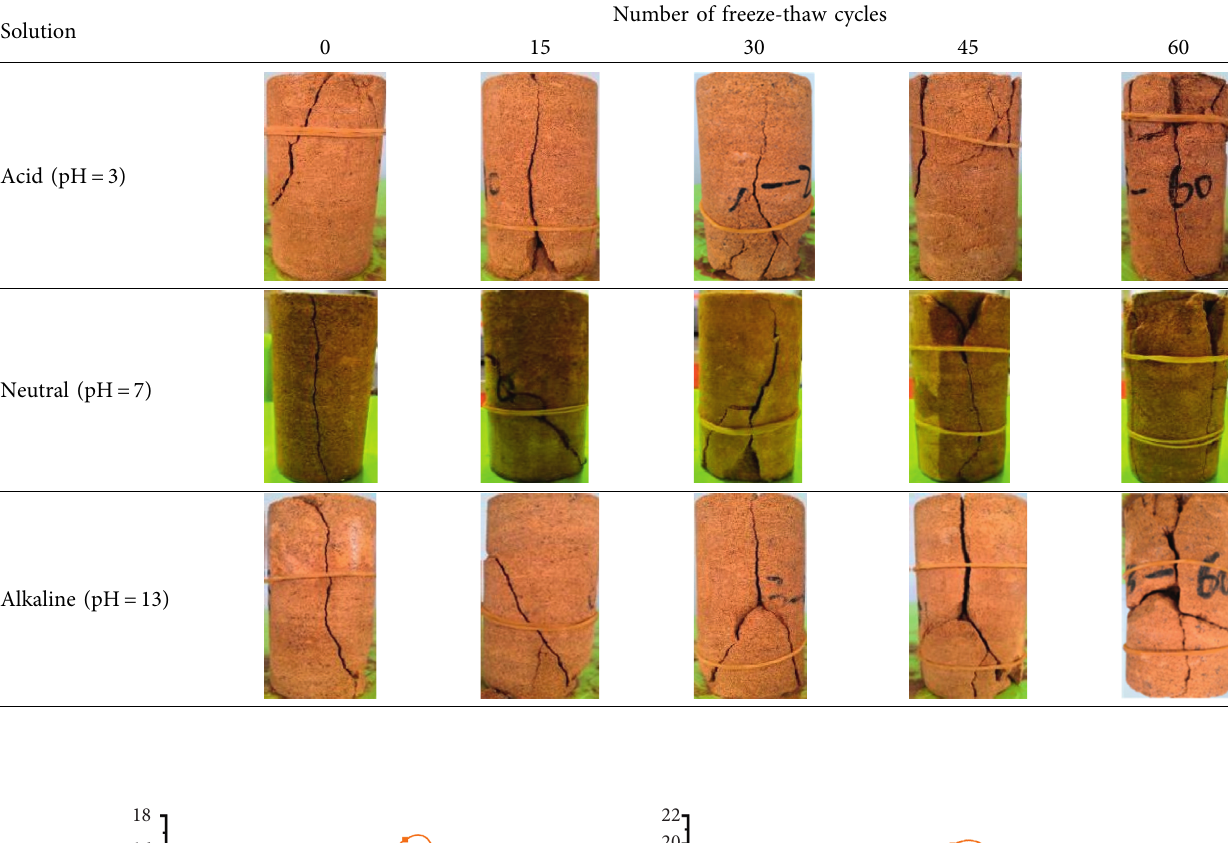
Table 2: Destructive forms of specimens under the coupling action of chemical solutions and freeze-thaw